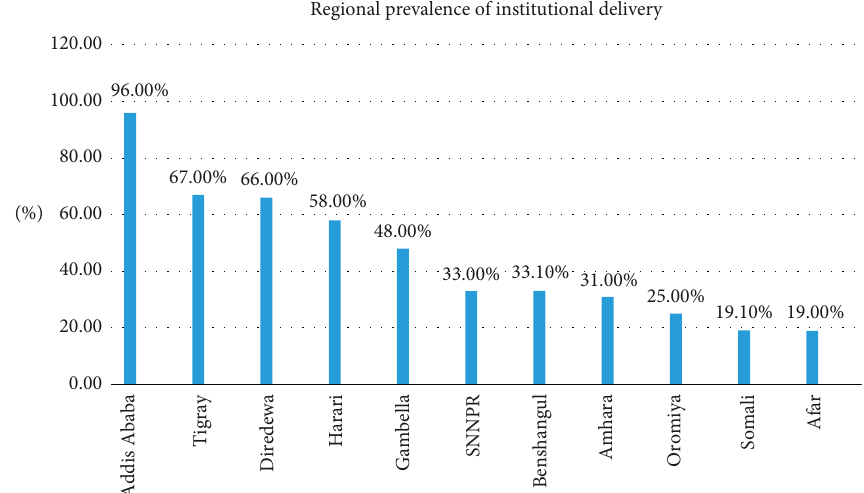
Figure 1: Regional prevalence of institutional delivery (source: shape file from Central Statistical Agency,